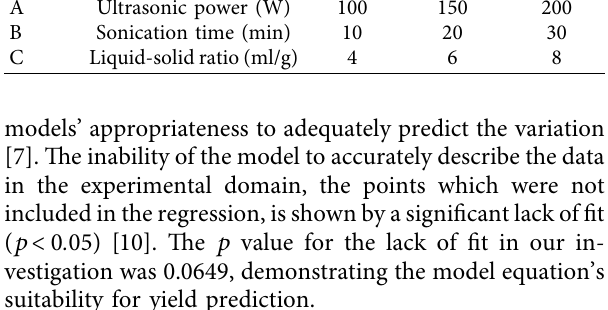
Table 1: Codes and levels of independent variables used in the response surface methodology (RSM) design. Symbol Independent